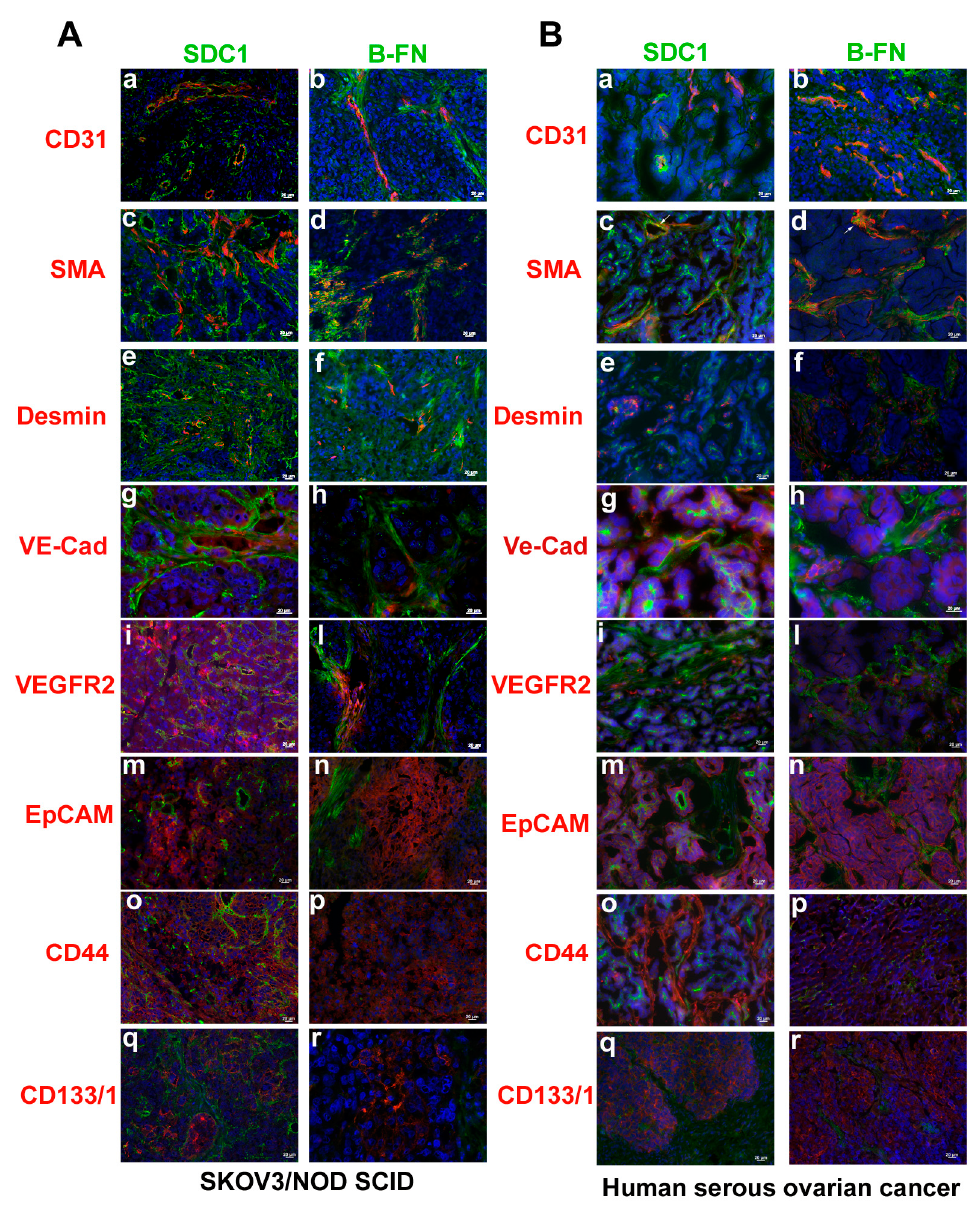
Figure 3. Expression of SDC1 and B-FN in ovarian carcinoma. Immunofluorescence analysis of cryostat sections of SKOV3 induced in NOD SCID mice ( A ) and human serous ovarian carcinoma biopsy ( B ) for SDC1 and B-FN expression with vascular markers CD31, SMA (smooth muscle actin), and Desmin, Vascular Mimicry markers VE-cadherin (VE-cad) and VEGFR2, and ovarian cancer stem cell markers EpCAM, CD44, and CD133/1, counterstained with DAPI. The merged signals are shown. Scale bars, 20 μ m.